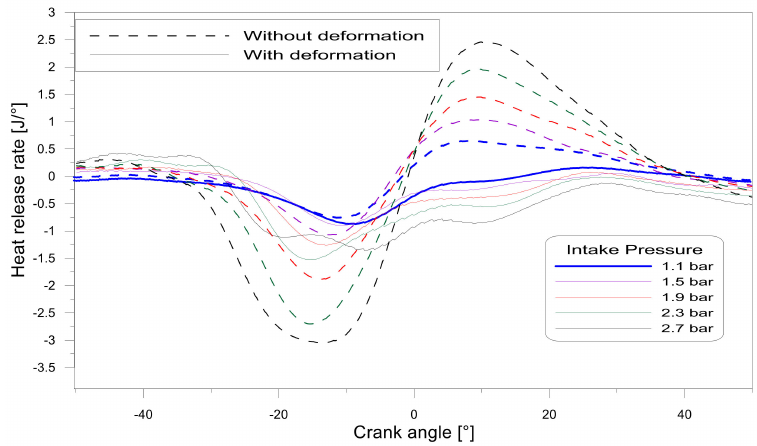
Figure 15. Heat release rate trace with and without volume